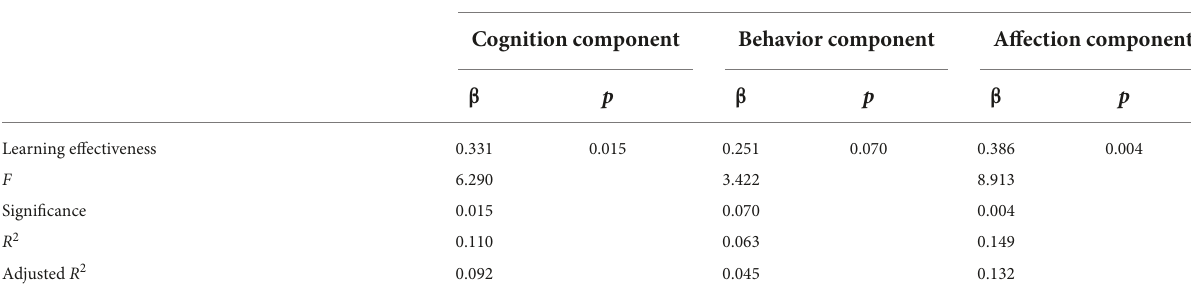
TABLE 14 The relationship between learning effectiveness and cognitive dimensions of learning attitude. Learning effectiveness (independent